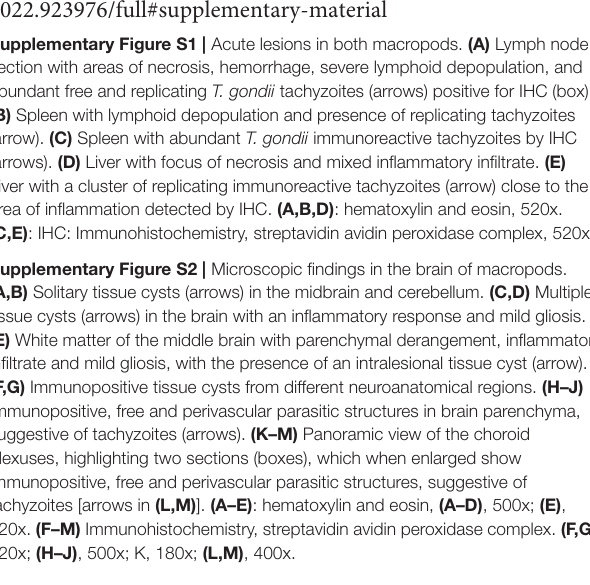
Supplementary Figure S1 | Acute lesions in both macropods. (A) Lymph node section with areas of necrosis, hemorrhage, severe lymphoid depopulation, and abundant free and replicating T. gondii tachyzoites (arrows) positive for IHC (box). (B) Spleen with lymphoid depopulation and presence of replicating tachyzoites (arrow). (C) Spleen with abundant T. gondii immunoreactive tachyzoites by IHC (arrows). (D) Liver with focus of necrosis and mixed inflammatory infiltrate. (E) Liver with a cluster of replicating immunoreactive tachyzoites (arrow) close to the area of inflammation detected by IHC. (A,B,D) : hematoxylin and eosin, 520x. (C,E) : IHC: Immunohistochemistry, streptavidin avidin peroxidase complex, 520x. Supplementary Figure S2 | Microscopic findings in the brain of macropods. (A,B) Solitary tissue cysts (arrows) in the midbrain and cerebellum. (C,D) Multiple tissue cysts (arrows) in the brain with an inflammatory response and mild gliosis. (E) White matter of the middle brain with parenchymal derangement, inflammatory infiltrate and mild gliosis, with the presence of an intralesional tissue cyst (arrow). (F,G) Immunopositive tissue cysts from different neuroanatomical regions. (H–J) Immunopositive, free and perivascular parasitic structures in brain parenchyma, suggestive of tachyzoites (arrows). (K–M) Panoramic view of the choroid plexuses, highlighting two sections (boxes), which when enlarged show immunopositive, free and perivascular parasitic structures, suggestive of tachyzoites [arrows in (L,M) ]. (A–E) : hematoxylin and eosin, (A–D) , 500x; (E) , 420x. (F–M) Immunohistochemistry, streptavidin avidin peroxidase complex. (F,G)